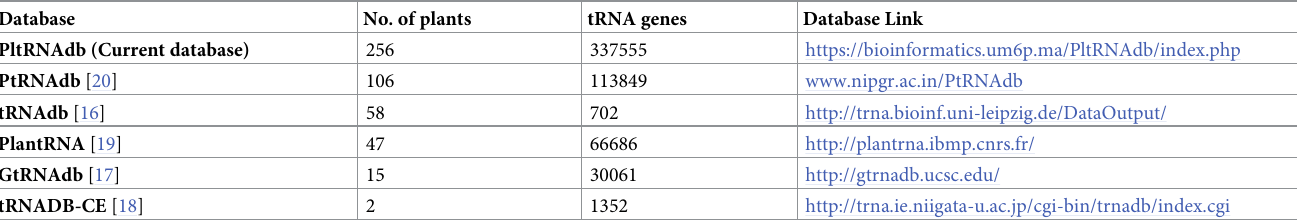
Table 1. Comparison between PltRNAdb (current database) and other tRNA